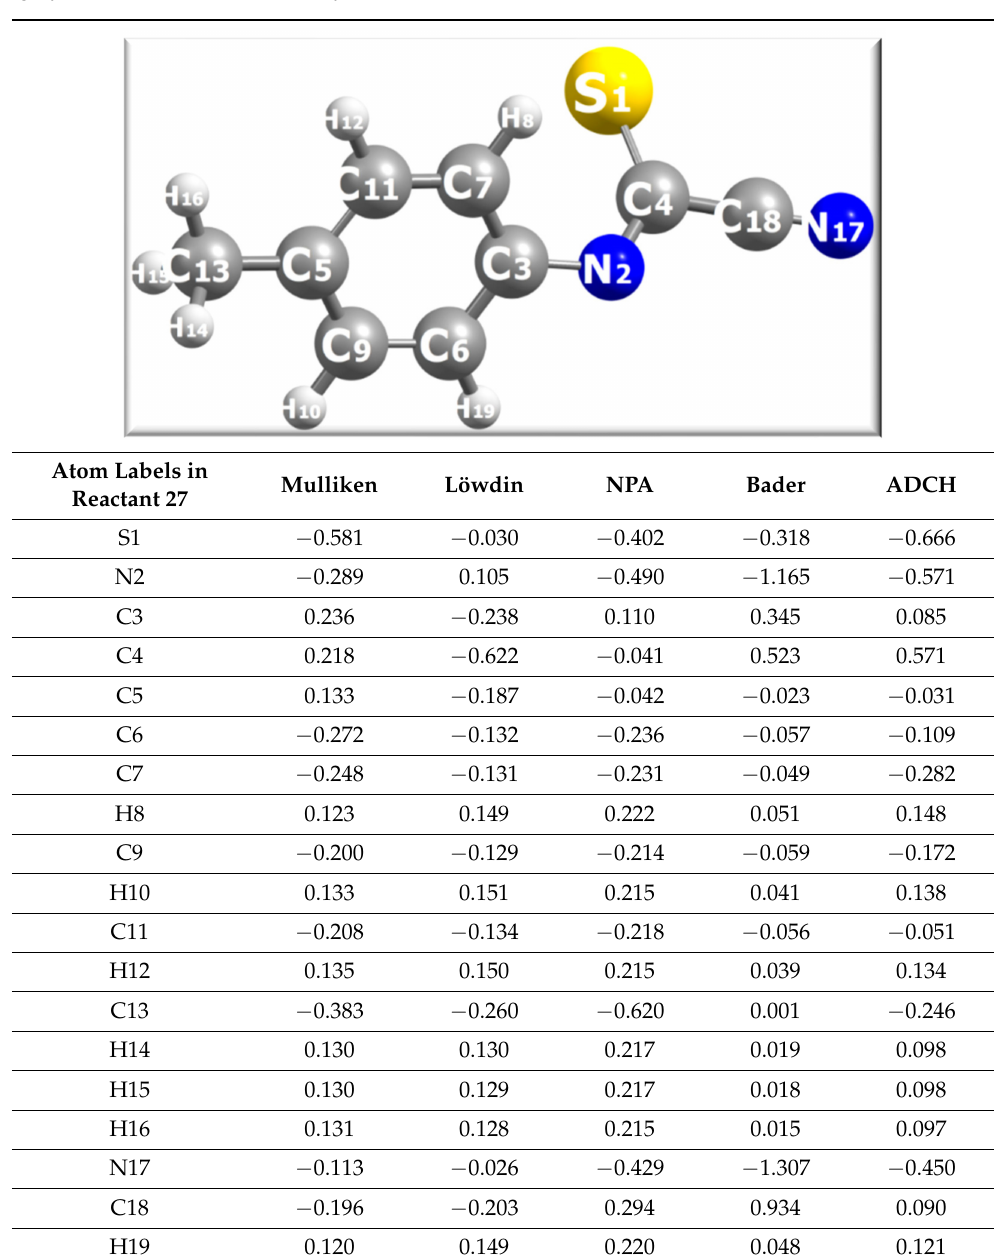
Table 2. Calculated atomic charges for the deprotonated form of reactant 27 computed at the B3LYP-D4/def2-TZVP level of theory in implicit ethanol as solvent. A ball-and-stick